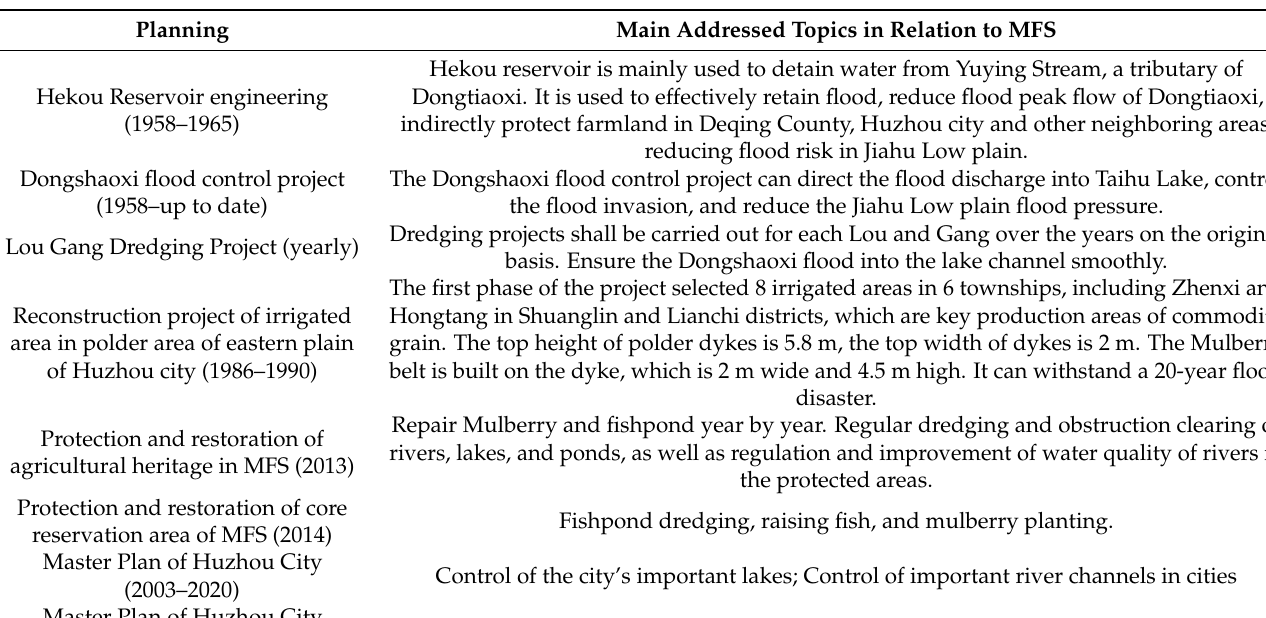
Table 7. Summary of the main planning tools at local level dealing with